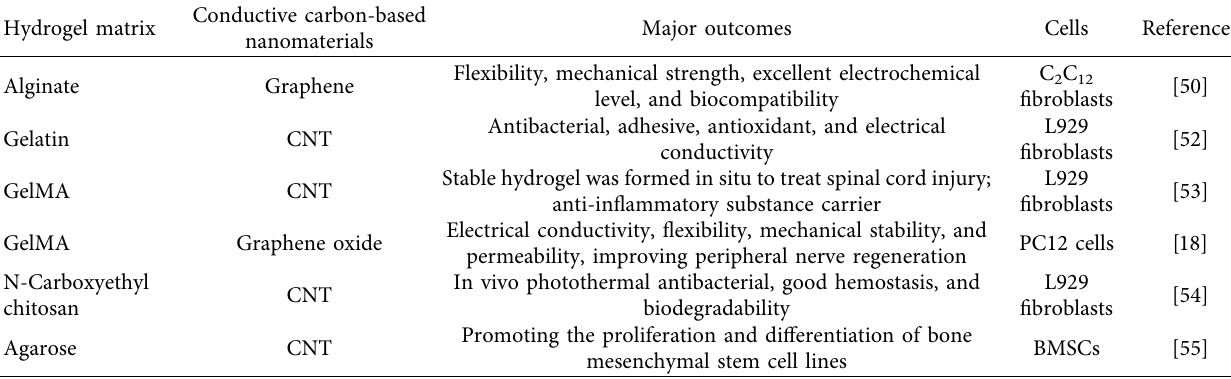
Table 3: Some applications of conductive graphene and CNTs hydrogels in biomedicine. Hydrogel